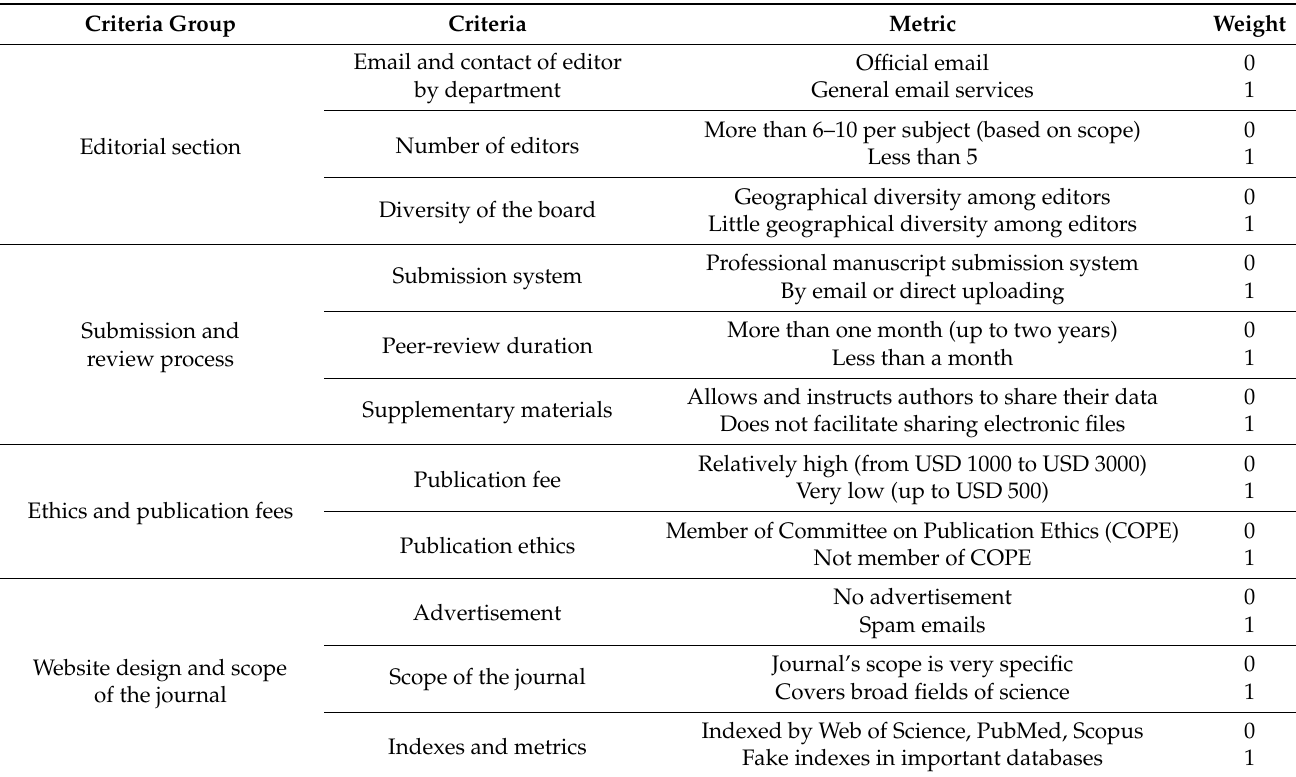
Table 3. Beall’s criteria for classifying predatory